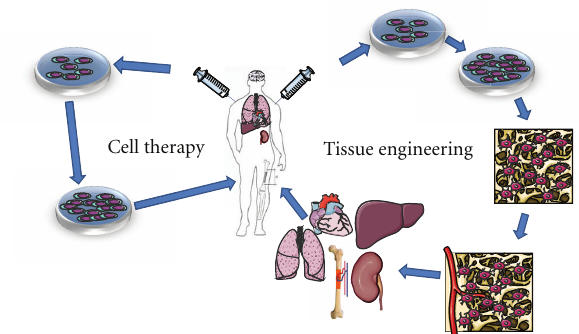
Figure 1: The two strategies of stem cell application in regenerative medicine. Stem cells are either isolated from the patient (auto- logous transplantation) or from other donors (allogenous trans- plantation). The cells are expanded in vitro and either applied di- rectly to the patient to substitute lost cells (“cell therapy”), or seed- ed into 3 dimensional sca ff olds (“Tissue engineering”) and di ff er- entiated into the demanded cell type. The composed artificial tissue construct is subsequently implanted into patients’ tissue